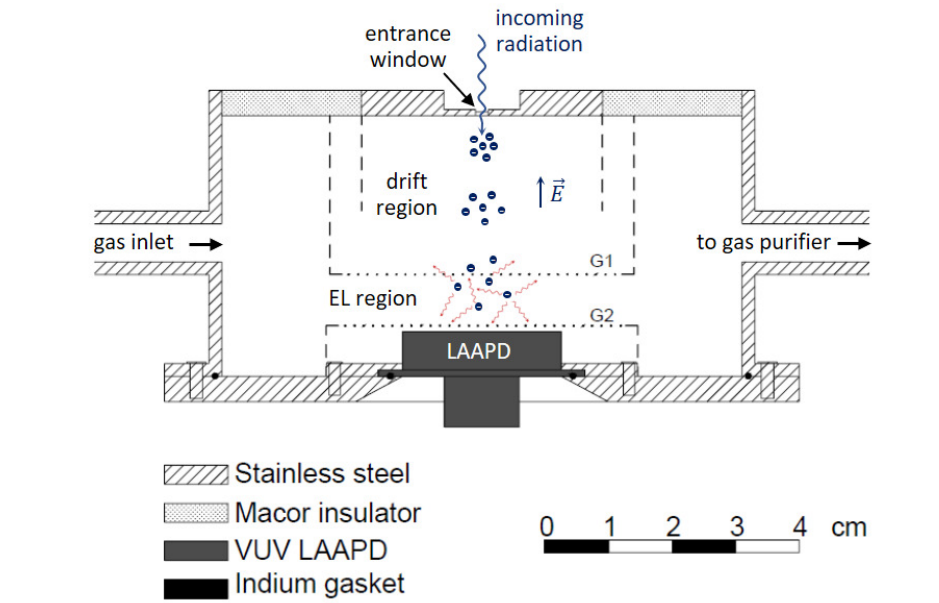
Figure 2 . Schematic of the Gas Proportional Scintillation Counter used for this work. A VUV- sensitive LAAPD is used as photosensor and the gas is continuously puri(cid:12)ed, circulating by con- vection through SAES St707